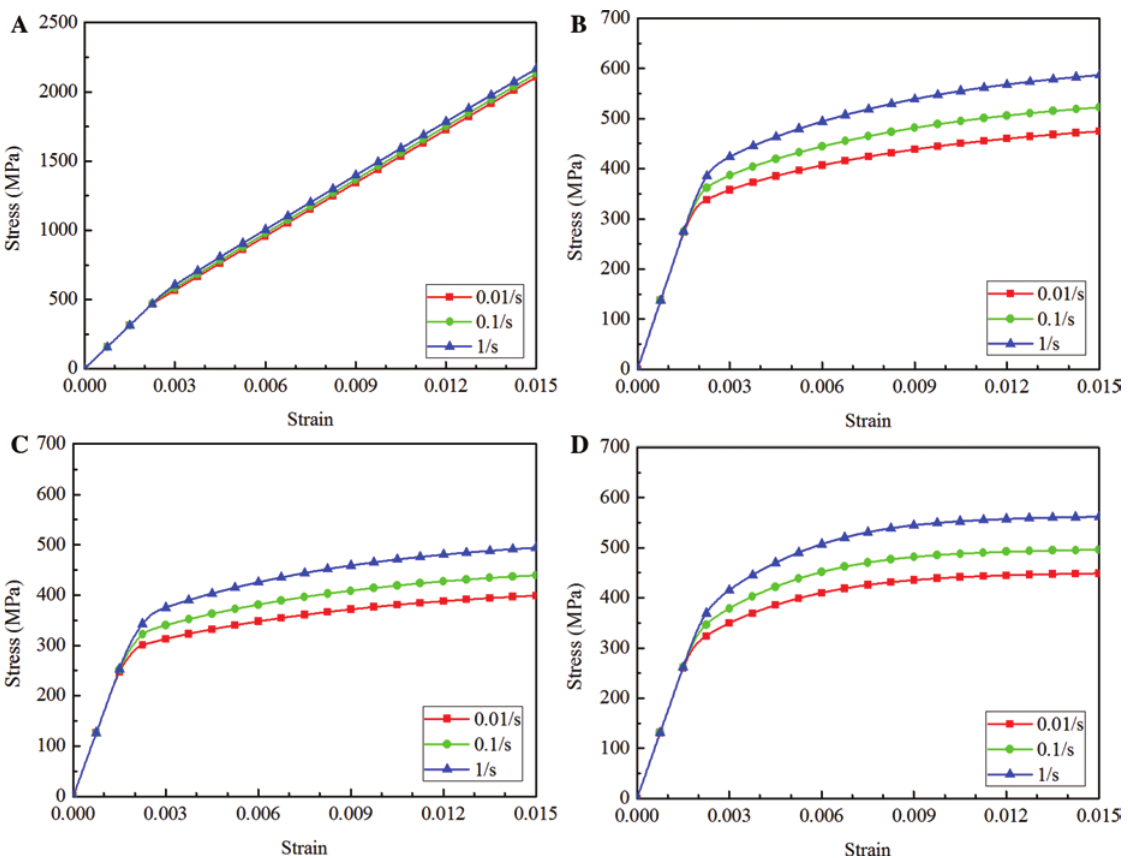
Figure 5: Stress-strain curves of MMCs at strain rates of 0.01/s, 0.1/s and 1/s for (A) 0 ° , (B) 30 ° , (C) 60 ° and (D) 90 ° off-axis orientations.